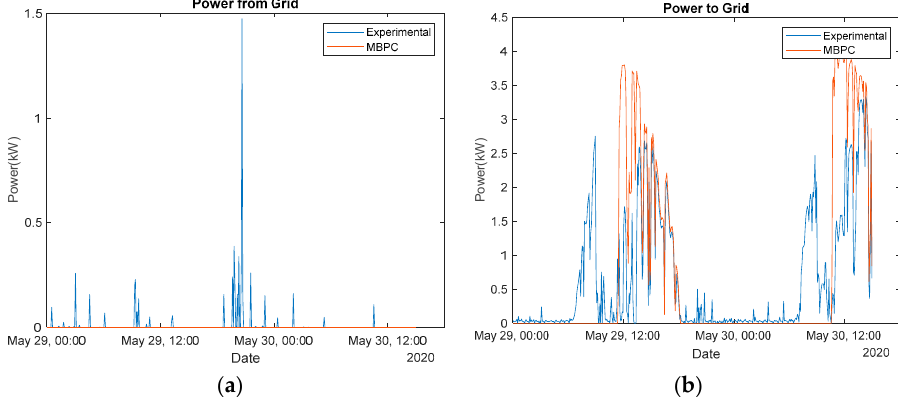
Figure 20. ( a ) Power imported from the grid. ( b ) Power exported to the grid (sunny